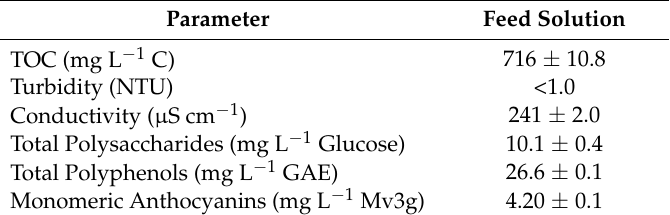
Table 1. Physical-chemical characteristics of the feed